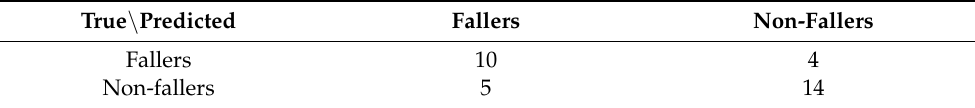
Figure 5. Gait parameters extracted from the simulated data [33]. ( a ) v u,std vs. v u,mean ; ( b ) v l,std vs. v u,mean ; ( c ) v m,mean vs. v u,mean . Table 4. Confusion matrix of the classification results of the test performed using actual data using the model tuned for the